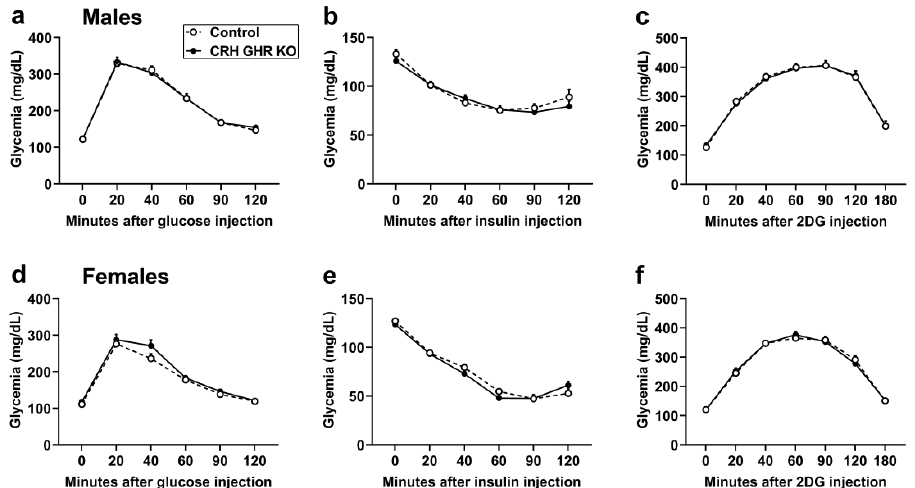
Figure 3. GHR ablation in CRH cells does not affect glucose homeostasis and counterregulatory response. ( a – c ) Glucose tolerance test ( a ), insulin tolerance test ( b ) and counterregulatory response ( c ) to 2-deoxy-D-glucose (2DG) in control ( n = 10) and CRH GHR KO ( n = 9) male mice. ( d – f ) Glucose tolerance test ( d ), insulin tolerance test ( e ) and counterregulatory response to 2DG ( f ) in control ( n = 16) and CRH GHR KO ( n = 11) female mice.